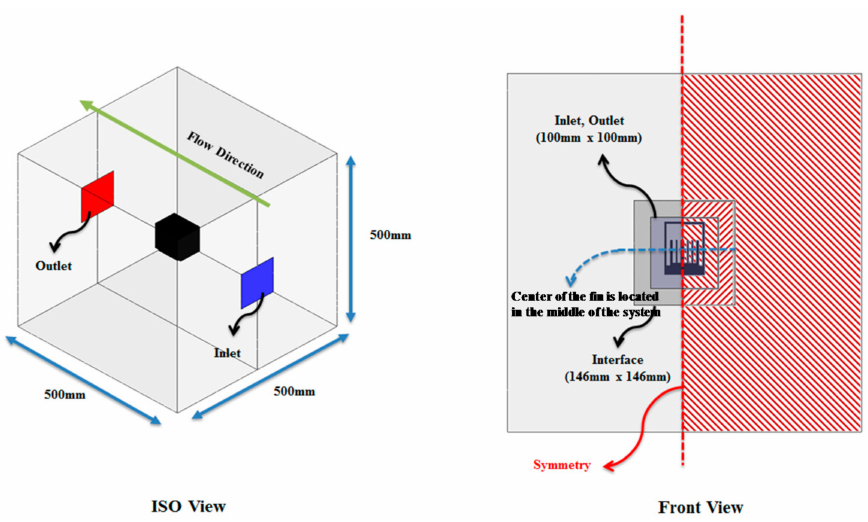
Figure 3. Boundary conditions of fluid region for numerical analysis.